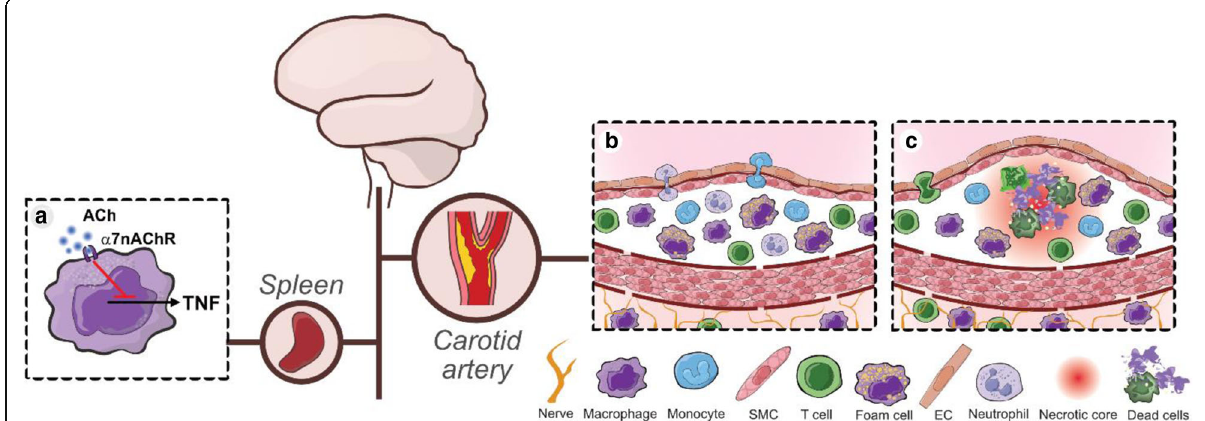
Fig. 1 Neural control of vascular inflammation. Neural circuits regulate inflammation and cytokine production. a In the inflammatory reflex, acetylcholine (ACh) acts through the alpha 7 nicotinic acetylcholine receptor subunit ( α 7nAChR) on macrophages to suppress pro-inflammatory cytokines such as TNF. Suggested neuro-immune cross talk in atherosclerosis: b The adventitia is innervated and contains immune cells that may interact with other layers of the vascular wall. In the early stages of atherosclerosis, local recruitment of inflammatory cells in the intimal layer of arteries progresses slowly. c As atherosclerosis progresses, the inflamed plaque eventually develops a necrotic core which increases plaque vulnerability and the risk of